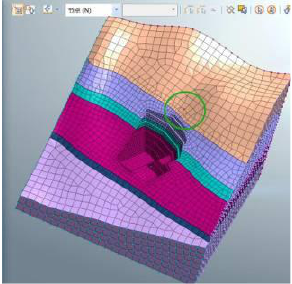
Figure 8. The stress time-history curve of blasting.